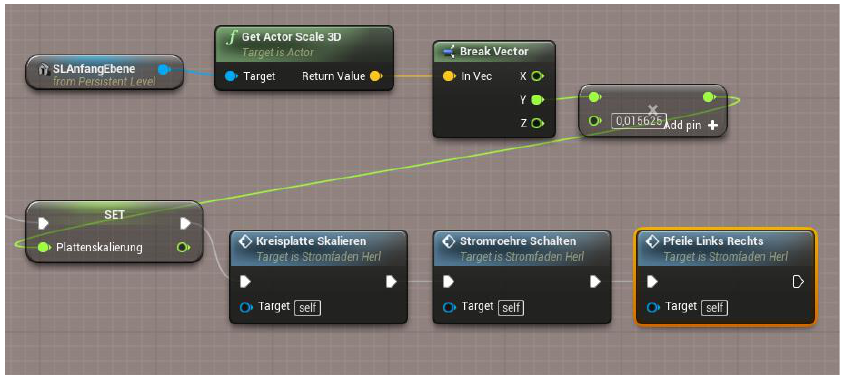
Fig. 2. Blueprint-code example: Shrinking flow tube to stream filament by setting actors and wiring the flow of